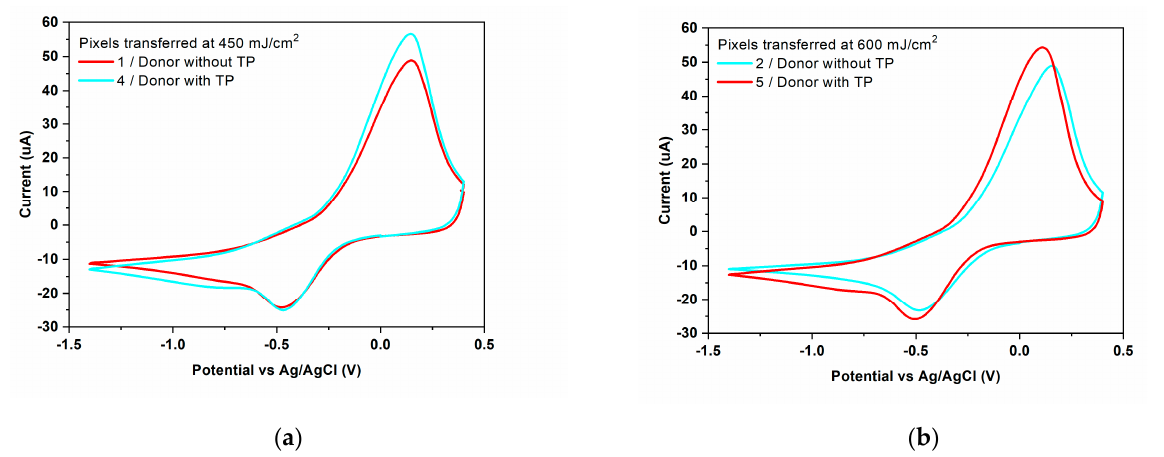
Figure 8. Cyclic voltammogram of Cu 2+ (100 ppm) in 0.1 M acetate buffer solution (pH = 5.0 upH) recorded on PEDOT:PSS: GO electrodes printed from a donor with a triazene polymer intermediate layer and fabricated at different laser fluences ( a ) laser fluence 450 mJ/cm 2 ; ( b ) 600 mJ/cm 2 .